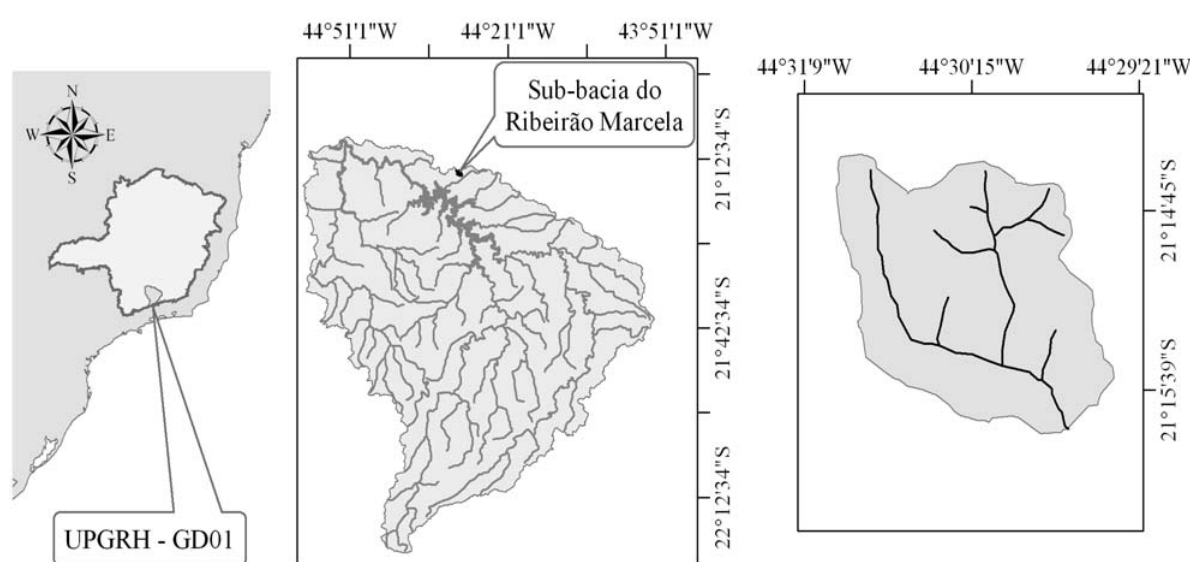
Figura 1. Localização da sub-bacia hidrográfica do Ribeirão Marcela em Minas Gerais e sua inserção na Unidade de Planejamento e Gestão dos Recursos Hídricos (UPGRH –